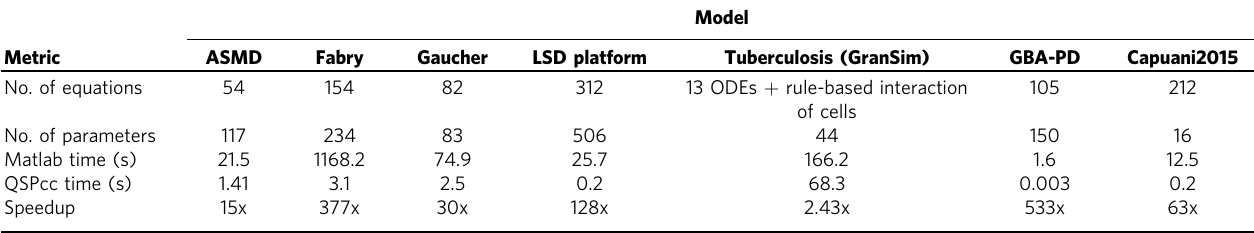
Fig. 1 QSPcc consistently delivers superior performances of different orders of magnitude compared to other solutions. The gradient violet to yellow depicts how many times the given combination model/translator is faster than MATLAB (the lighter, the better). The running time of each model was measured averaging fi ve different executions. White blocks represent models that cannot be translated to C even after a signi fi cant hands-on effort (see Comparison with other tools for further details). a Comparison of 5 SBML-based model simulation solutions on 8 real-world published SBML models retrieved from BioModels, b comparison of 3 MATLAB-based modeling solutions on 16 real-world models for which no SBML exist. They come from published literature retrieved from Pubmed ( “ PAPER ” ) or as benchmarks of the tool “ MOCASSIN ” , from “ MATLAB ” samples, from the Lysosomal Storage Disorders family of models ( “ LSD ” ), or in-depth “ Case Study ” discussed in the text 39 – 46 . Table 1 Models of signi fi cant biological complexity and clinical relevance the authors developed leveraging the QSPcc